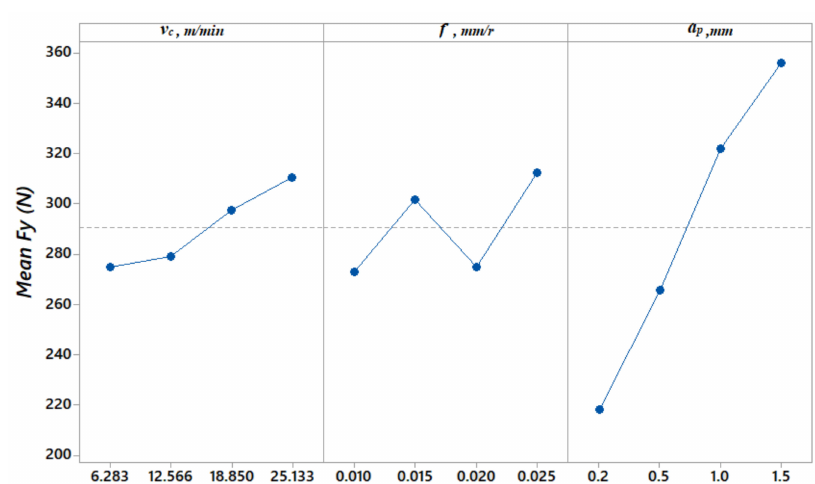
Figure 3. Main e ff ect plots for F y cutting